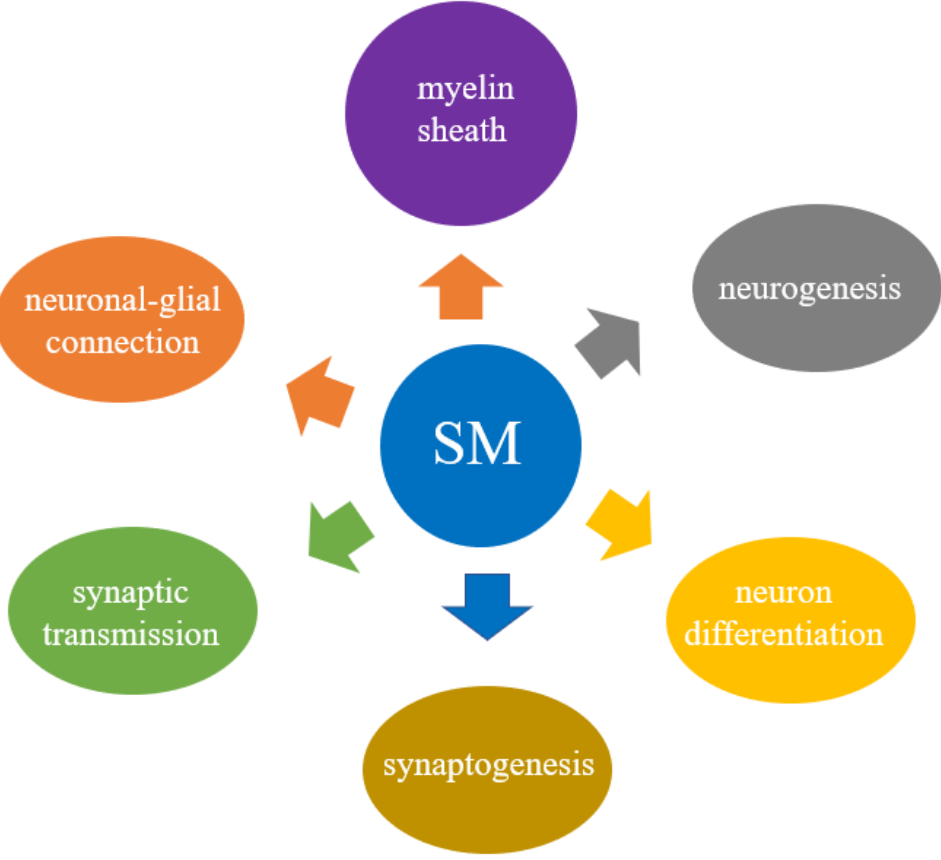
Figure 2. Schematic representation of the main roles of sphingomyelin in brain physiology. Descrip- tion in the text (Sections 3.1 and